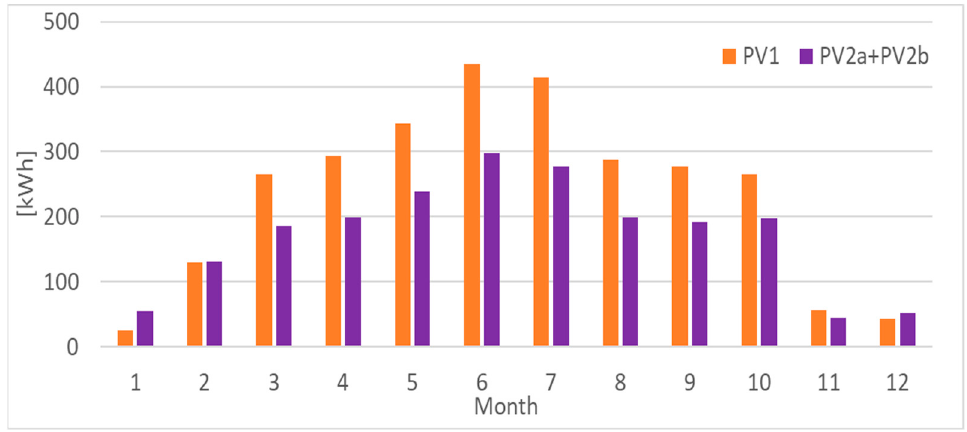
Figure 17. Daily energy generation by PV2a and PV2b sections in 2018 (own measurement data).